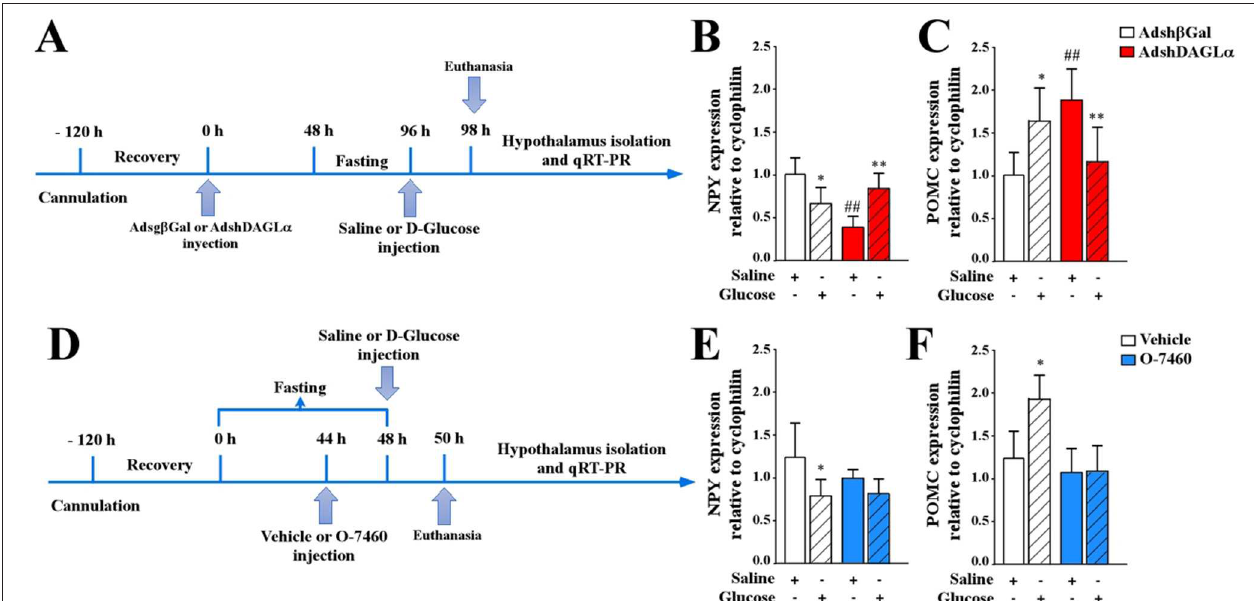
FIGURE 5 | Effect of AdshDAGL α injected in the 3V on the expression of hypothalamic neuropeptides critical for food intake. (A) Experimental protocol using adenoviruses. Adult female rats were stereotaxically cannulated into the 3V. After 120h of recovery, the rats were injected with Adsh β Gal or AdshDAGL. At 48h post-injection, the rats were fasted for 48h and subsequently injected with saline buffer or 50mM D-glucose (dashed bars). At 2h post-3V i.c.v. Injection, the animals were sacrificed, and the hypothalamus was dissected for RNA extraction and qRT-PCR analysis. (B,C) qRT-PCR analysis of NPY (B) and POMC (C) neuropeptide expression in rats transduced with Adsh β Gal (open bars) or AdshDAGL α (red bars). (D) Experimental protocol using the O-7460 inhibitor. At 48h post-injection, the rats were fasted for 44h and injected with vehicle (open bars) or inhibitor (blue bars). After 2h, they were injected with saline buffer or 50mM D-glucose (dashed bars). At 2h post-3V i.c.v. injection, the animals were sacrificed, and the hypothalamus was dissected for RNA extraction and qRT-PCR analysis. (E,F) qRT-PCR analysis of NPY (E) and POMC (F) neuropeptide expression. ANOVA * , # p < 0.05; ** , ## p < 0.01. Bars represent average ± S.D for 5–6 independent